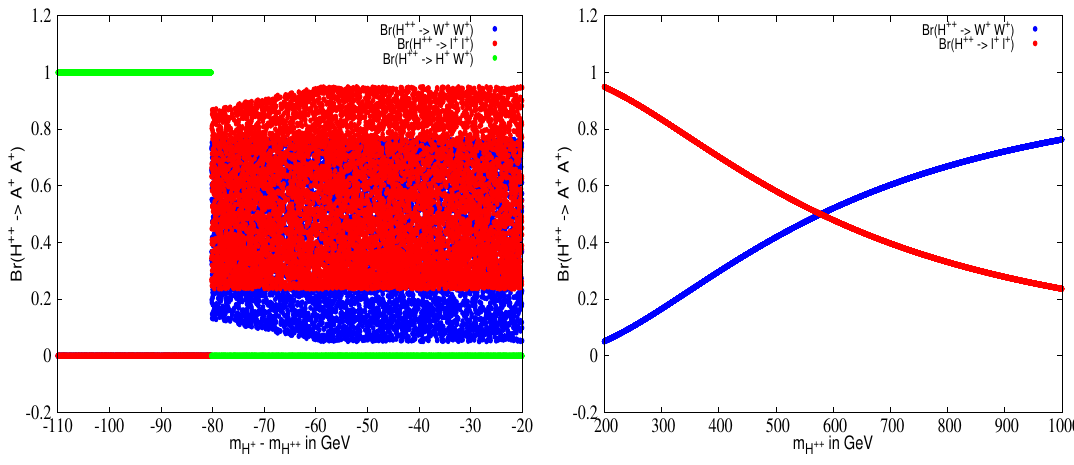
Figure 2 . Distribution of various branching ratios of H (cid:6)(cid:6)